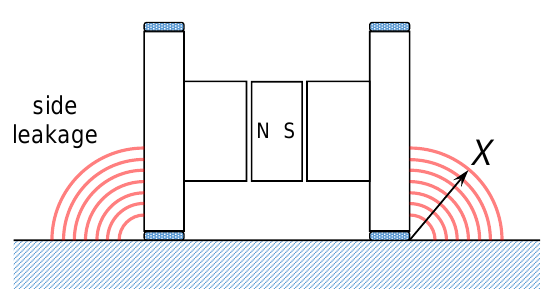
Figure 3. Leakage fluxes from the sides of the wheels to the surface.